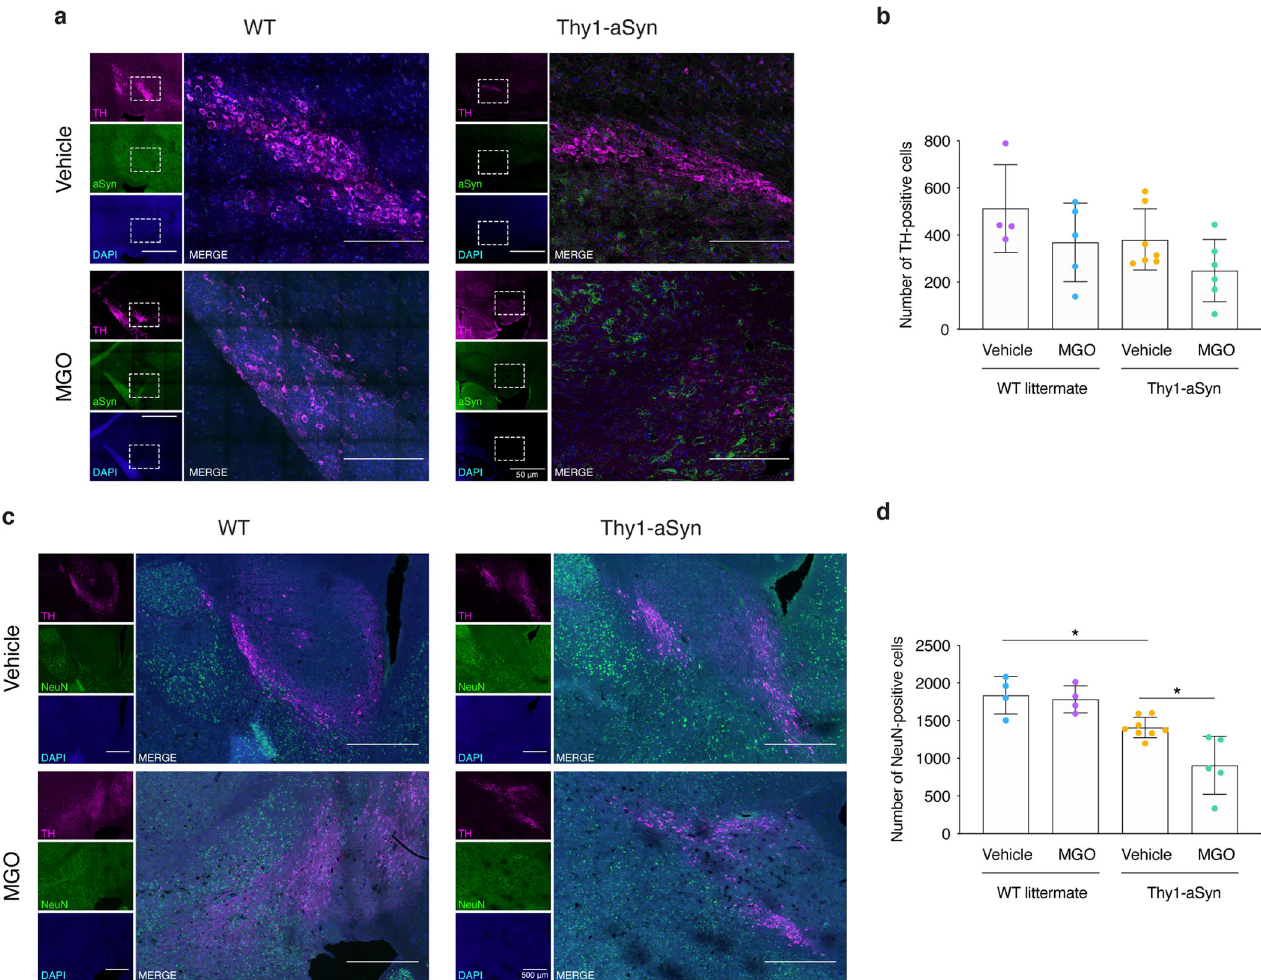
Fig. 3 MGO-treatment induces the loss of NeuN-positive neurons in the SNpc. Wild-type littermate (WT) and Thy1-aSyn transgenic mice received an intracerebroventricular (ICV) injection of MGO or vehicle (PBS). a Representative micrographs of brain sections immunostained for TH (magenta), aSyn (green), and DAPI (blue). Merge signal is shown. Scale bar = 50 μ m. Depicted area of substantia nigra (dashed square) is shown. Scale bar = 200 μ m. b The number of TH-positive cells per experimental group is shown. c Representative micrographs of brain sections of the substantia nigra immunostained for TH (magenta), NeuN (green), and DAPI (blue). Merge signal is shown. Scale bar = 500 μ m. d The number of NeuN-positive cells per experimental group is shown. At least n = 4 in all groups, data in all panels are average with error bars representing standard deviation, ordinary one-way ANOVA, * p <